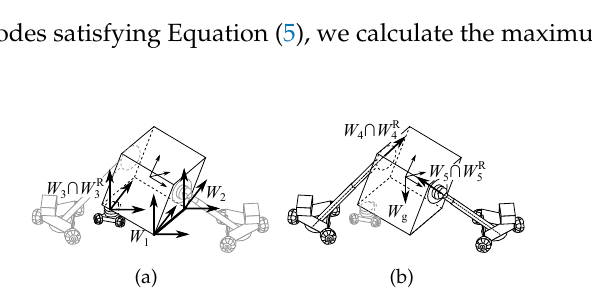
Figure 8. Wrench spaces spanned by ( a ) forces applied by the environment–object and the passive robot–object contacts and ( b ) forces applied by the active robot–object contacts and the gravitational